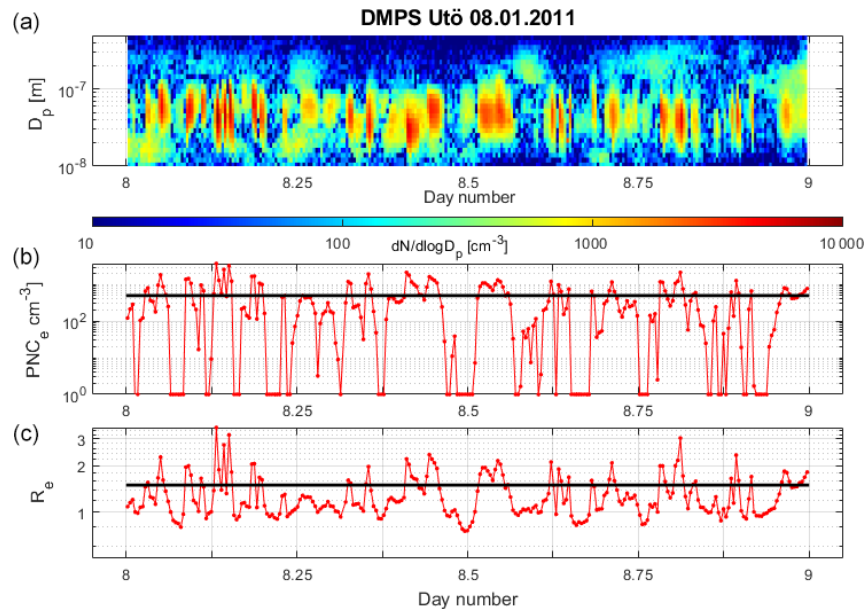
Figure 3. An example of the time series of (a) the number size distribution of excess particles (NSD e ), (b) the particle number concentration of excess particles (PNC e ), and (c) the ratio of the ambient particle number concentration to the background particle number concentration ( R e ) for a single day. In panels (b) and (c) the plume detection limits have been marked with black